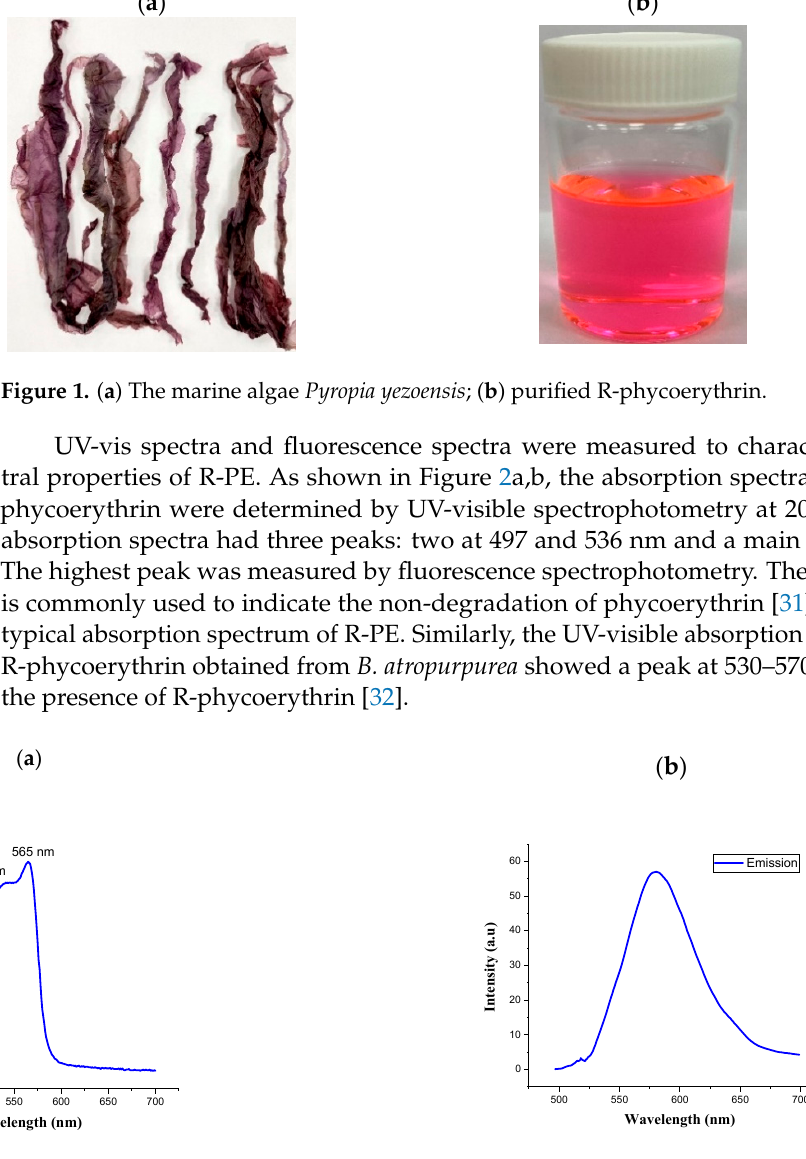
Figure 2. ( a ) Absorption spectrum of R-phycoerythrin; ( b ) fluorescence spectrum of R-phycoerythrin after excitation at 565 nm.